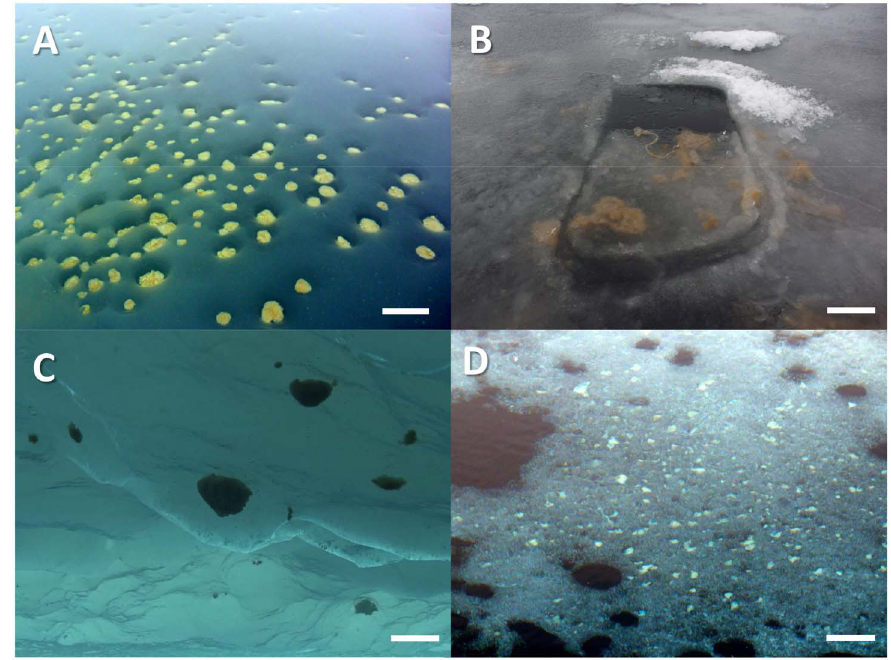
Figure 2. Distribution of aggregates in melt ponds. Degraded pennate aggregates in cryoconite holes at the bottom of a partially open melt pond at station PS78/3_212 (A). Melosira filaments hanging from newly formed ice covering an open melt pond at station PS80/3_349 (B). Spherical floating aggregates below sea ice at station PS80/3_237 (Image taken with the ROV Ronja (Courtesy Alfred Wegener Institute Helmholtz Center for Marine and Polar Research (AWI)) (C). Degraded Melosira filaments trapped at the bottom of a partially open melt pond at station PS80/3_224 (D). Scale bar=20 cm.